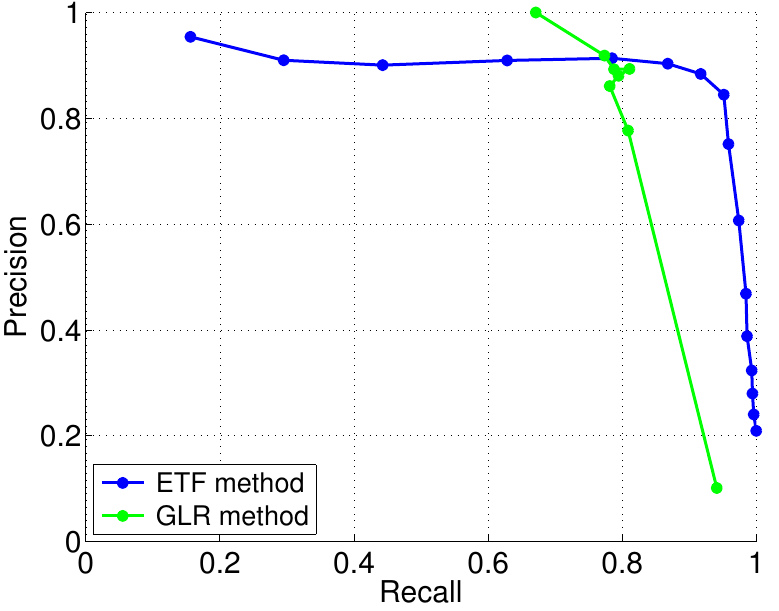
Figure 7. Precision-recall curve for TREFEX and GLR algorithms. The considered sensor is the MiCS